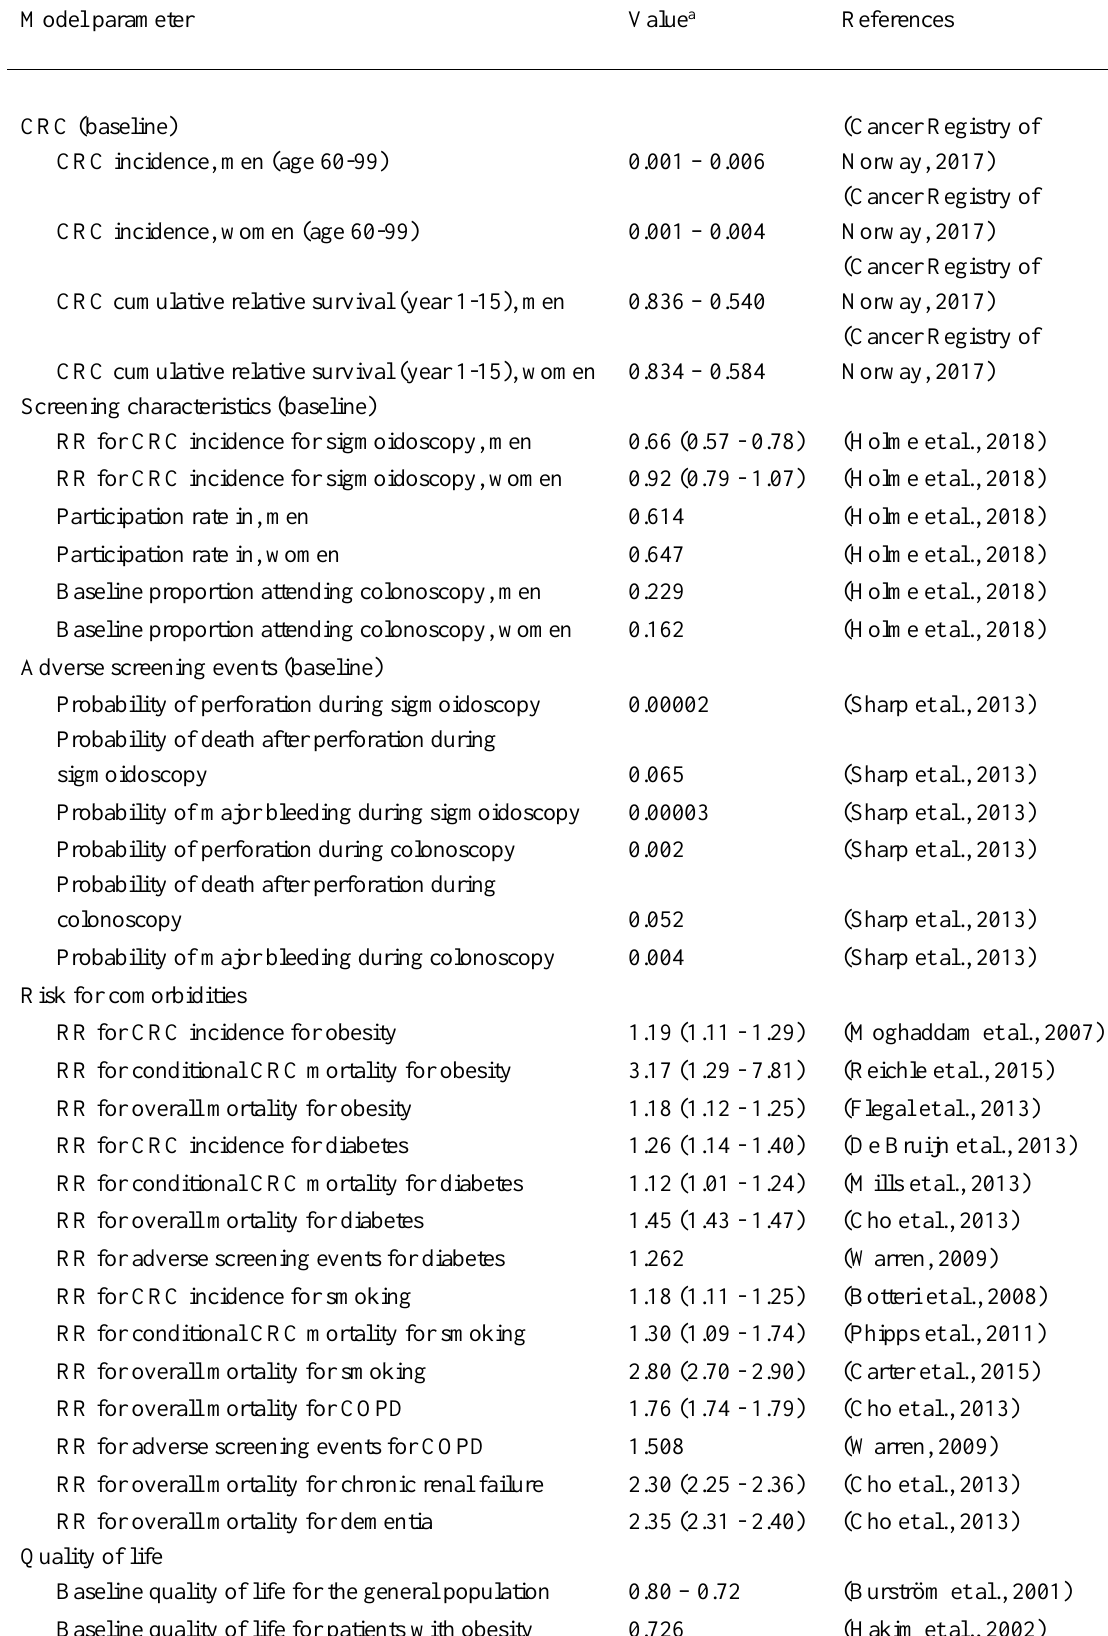
Table 1: Values for key model parameters used in the analysis. Costs in 2017 Euros. Model